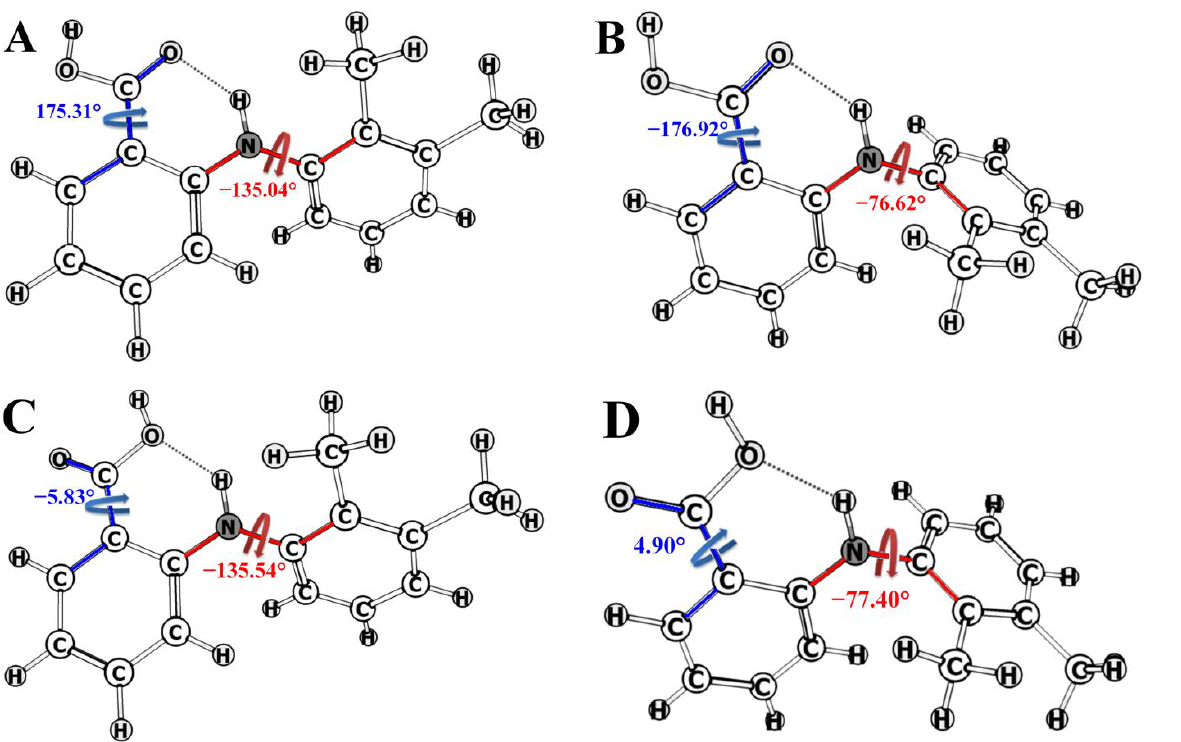
Figure 4. Structures of the MFA conformers and dihedral angles τ 1 [C 2 -N-C 3 -C 7 ] (red) and τ 2 [O=C 1 -C 13 -C 6 ] (blue).